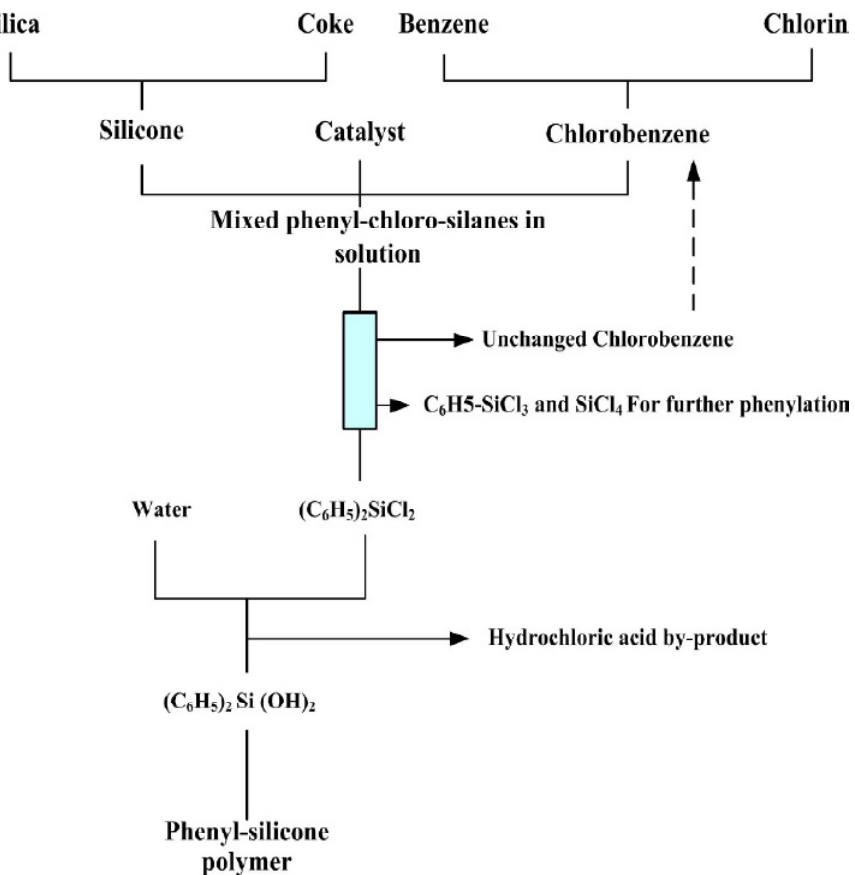
Fig. 5. Direct method: Phenyl-silicone polymer